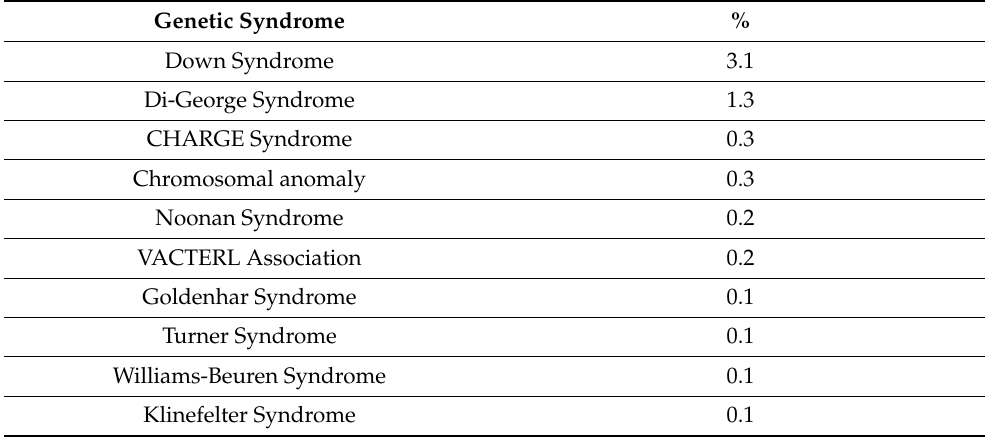
Table modified according to Jahn, Annika (2022): Körperliche Aktivität und Sportver- halten bei Kindern und Jugendlichen mit angeborenen Herzfehlern—eine deutschlandweite Analyse. Universität Ulm. Dissertation.